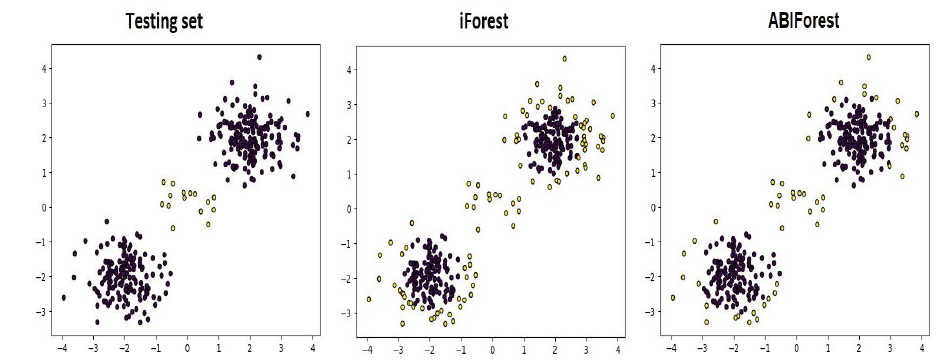
Figure 9. Comparison of the test set generated for the Normal dataset (the left panel), predictions obtained by iForest (the central panel), and predictions obtained by ABIForest (the right panel).